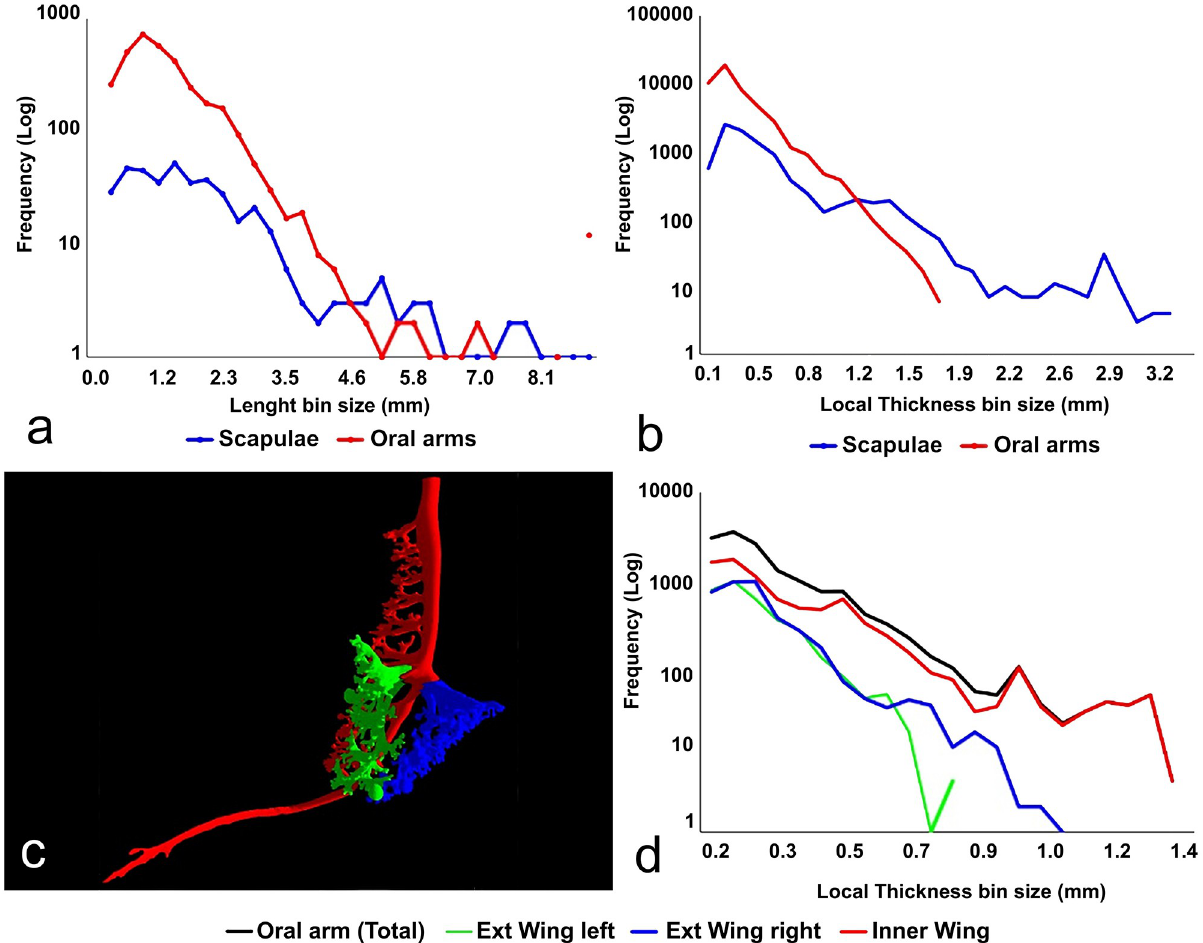
Fig 8. Morphometric analysis of the scapulae vs. the oral arms and thickness analysis of the three-winged portions in an oral arm. (a) Frequency plots of the branch lengths. (b) Thickness of the scapulae vs. the oral arms. (c) 3D isosurface rendering of a single oral arm. (d) Frequency histogram of the LT values within the three